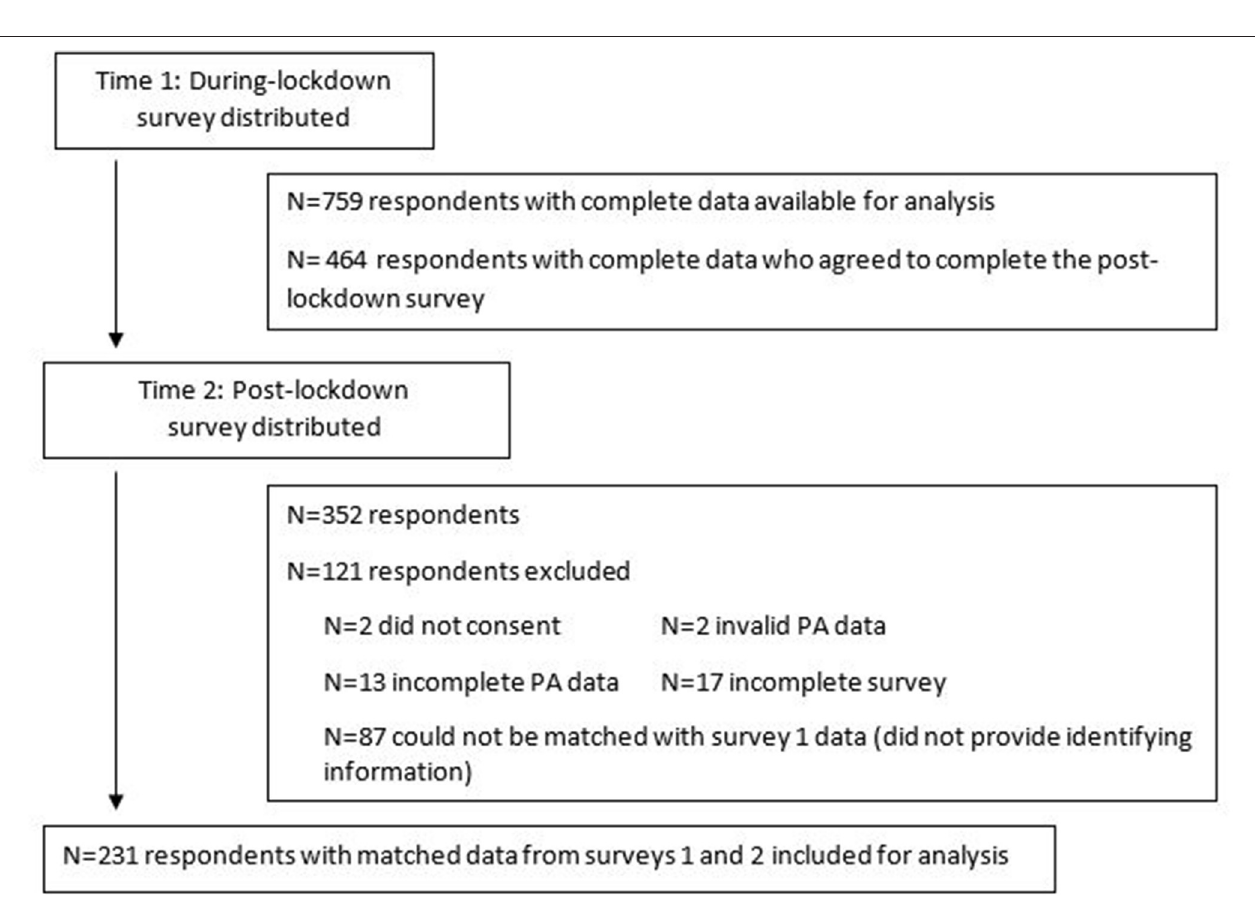
FIGURE 1 | Survey responses during-lockdown (Time 1) and post-lockdown (Time